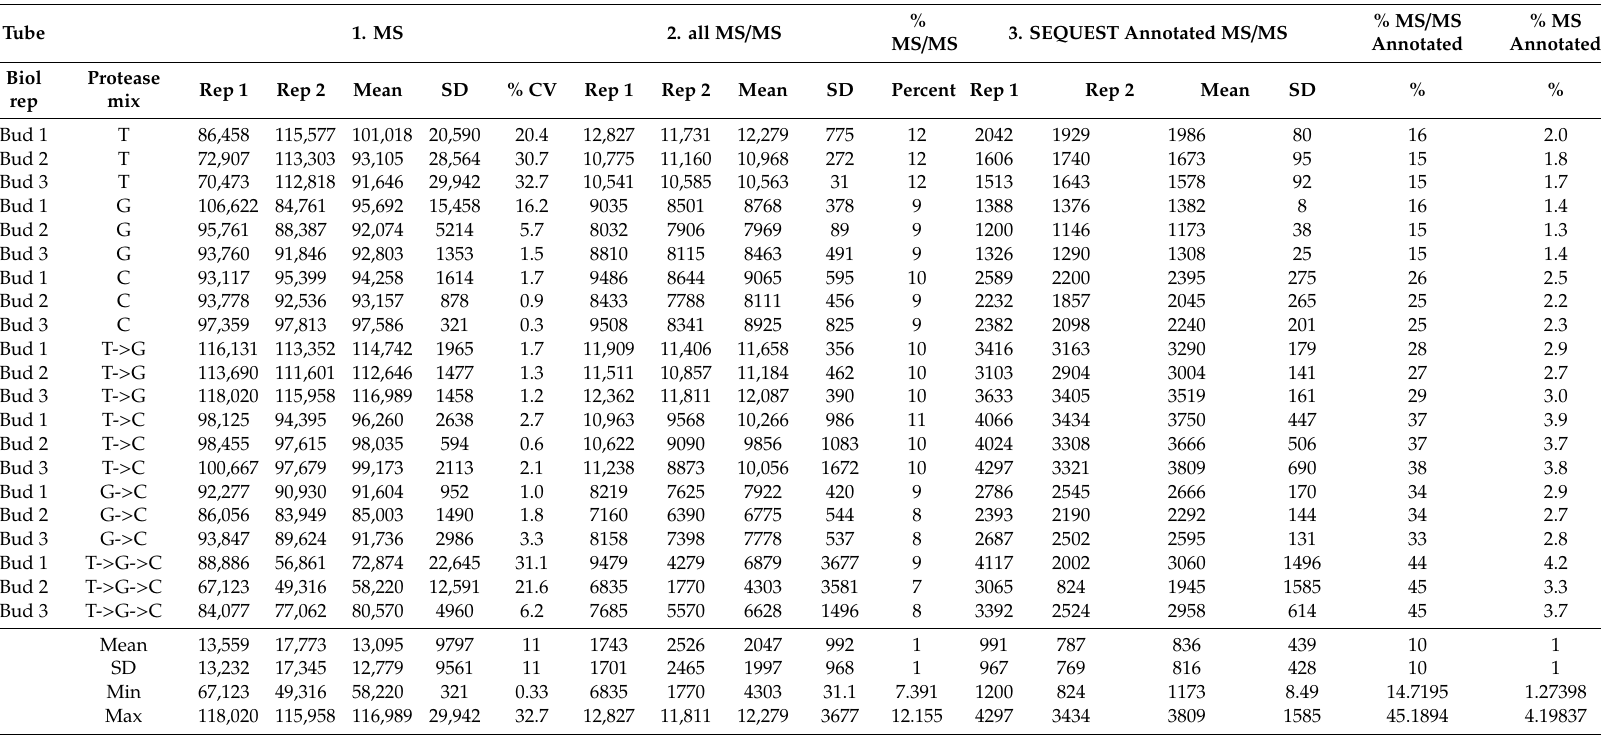
Table 2. Number of MS peaks, MS / MS spectra and MS / MS spectra annotated in SEQUEST for each of the medicinal cannabis digests. For protease legend, refer to Figure 1. An arrow (- > ) indicates the order in which the proteases were